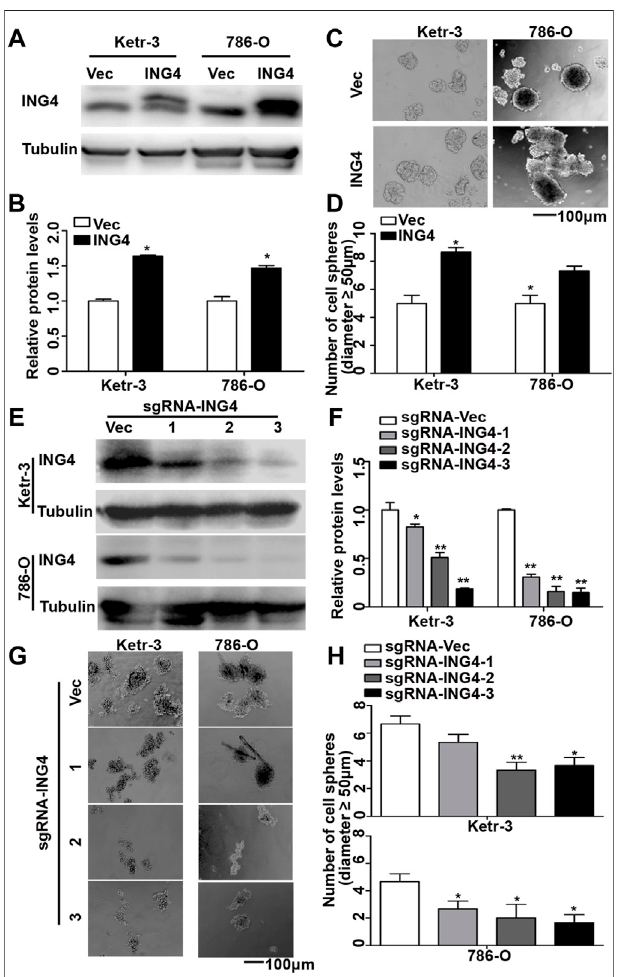
FIGURE 2 | ING4 increased the expression of stem cell markers in RCC cells. (A – B) Real-time PCR was used to test the relative mRNA expression of stemcellmarkersOCT4,CD44,NANOG,andMYCinING4-overexpressedor knockdown Ketr-3 and 786-O cells compared to the respective vector control. (C – E) Western blot was performed to test the protein expression levels of OCT4, CD44, NANOG, and MYC in ING4-overexpressed or knockdown Ketr-3 and 786-O cells and relative protein expression was normalized to that of the respective α -tubulin. Data are presented as mean ± standard deviation. *p < 0.05, **p <